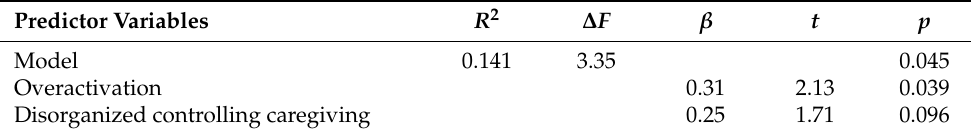
Table 5. Multiple regression on child externalizing behavior ( n =